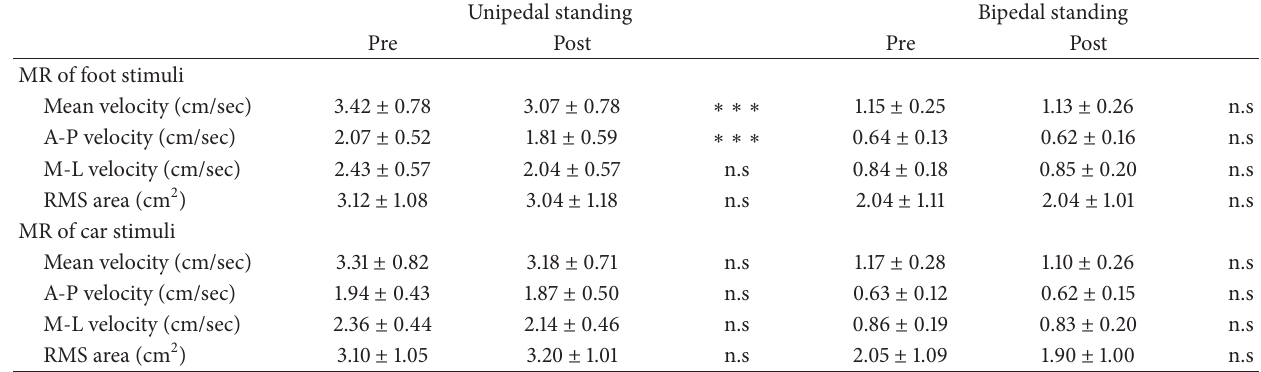
Table 1: Comparison of pre- and postintervention in each sway value for two standings in the two kinds of interventions in Experiment 1. Unipedal standing Bipedal standing Pre Post